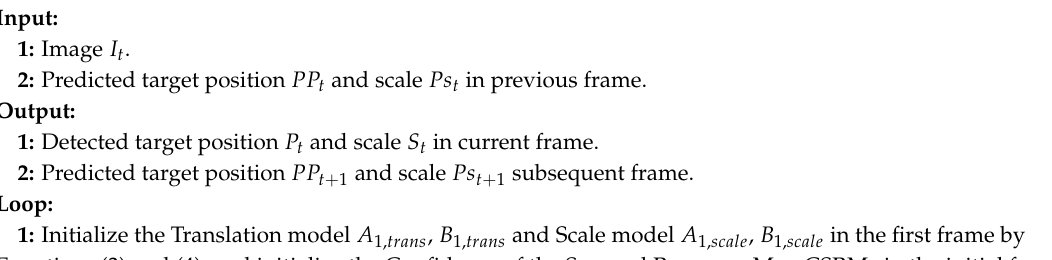
Algorithm 1. MACF tracking